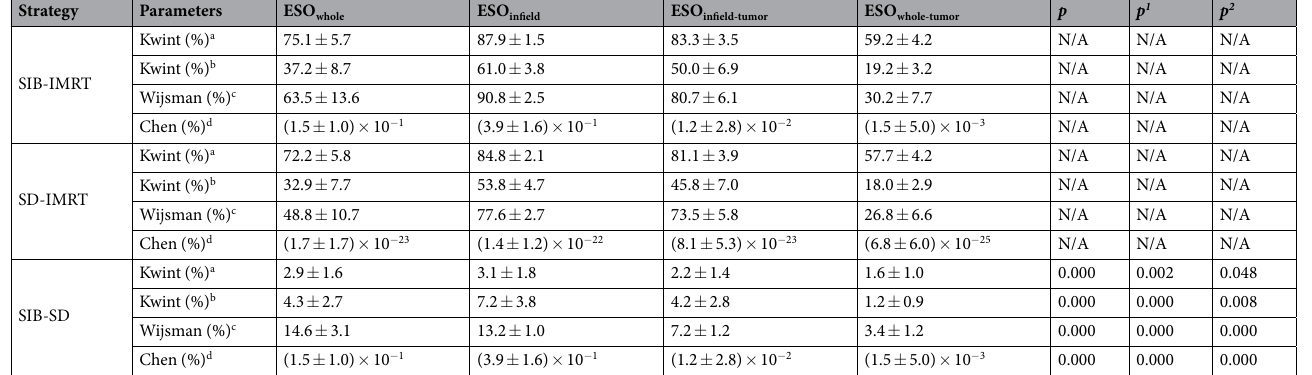
Table 3. Esophageal toxicity prediction for four Des. Abbreviations: SIB-IMRT = intensity-modulated radiation therapy with simultaneous integrated boost; SD-IMRT = standard-dose intensity-modulated radiation therapy; SIB-SD = the difference in predicting value between the SIB-IMRT and SD-IMRT plans; ESO whole = the entire esophagus, including the tumor; ESO infield = the portion of ESO whole within the treatment field; ESO infield-tumor = the portion of ESO infield , excluding the tumor; ESO whole-tumor = the portion of ESO whole , excluding the tumor. Kwint = Kwint model; Wijsman = Wijsman model; Chen = Chen model. N/A = not available. p 1 : ESO whole vs. ESO whole-tumor ; p 2 ESO infield vs. ESO infield-tumor . a Indicates Kwint model for predicting grade ≥ 2 acute esophageal toxicity. b Indicates Kwint model for predicting grade ≥ 3 acute esophageal toxicity. c Indicates Wijsman model for predicting grade ≥ 2 acute esophageal toxicity. d Indicates Chen model for predicting late esophageal